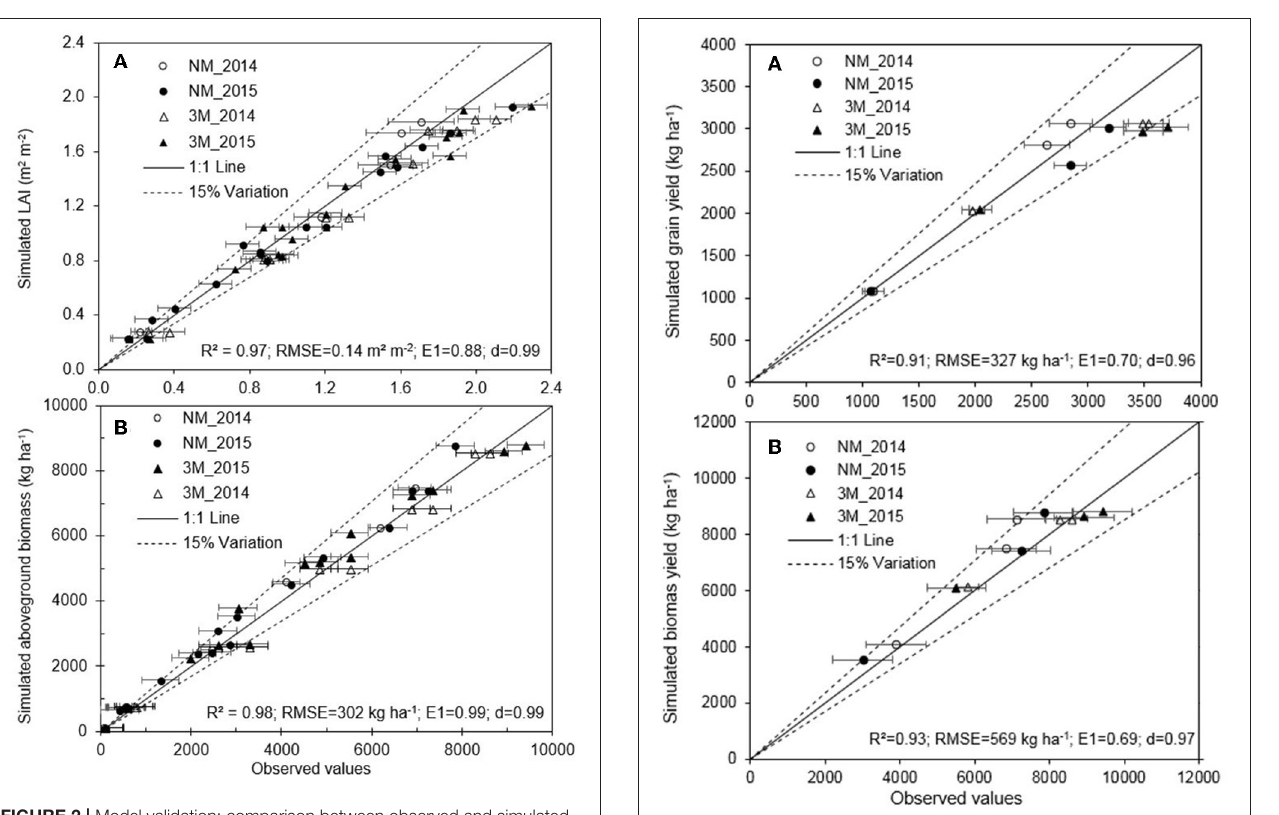
FIGURE 3 | Model validation: comparison between observed and simulated maize grain (A) and aboveground biomass (B) yield at harvest as affected by combined application of 0 (NM) or 3 (3M) t ha − 1 of manure and 0 (NF), 50 (50F), or 100% (100F) of the recommended mineral fertilization rate (broadcast fertilizer) over 2 years. Error bars, standard deviation ( n = 3); RMSE, root mean-square error; E1, coefficient of efficiency; d, index of